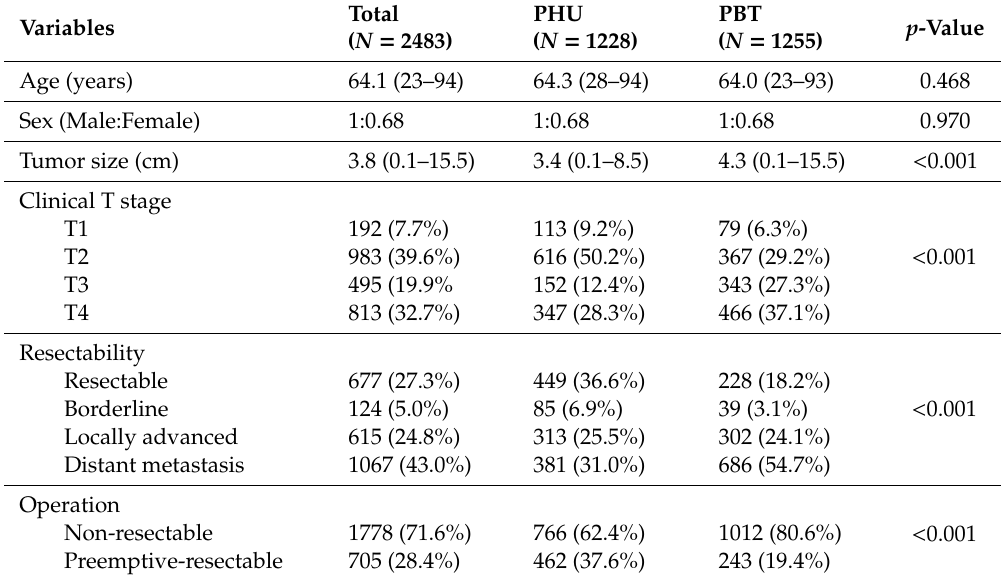
Table 1. Demographics and clinicopathological features of overall